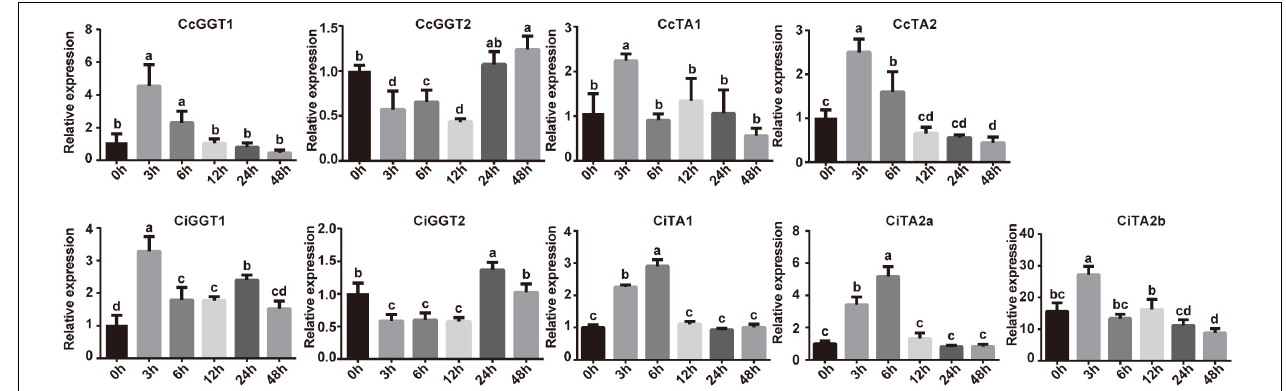
FIGURE 7 | Expression analysis of GGT and TA genes induced by wound stress in Chinese hickory and pecan by RT-qPCR. The analysis was conducted based on three biological replicates and three technical replicates for each sample. The error bars represented the standard deviations of nine replicates. Different letters indicated significant differences according to the Tukey–Kramer test ( P < 0.05).